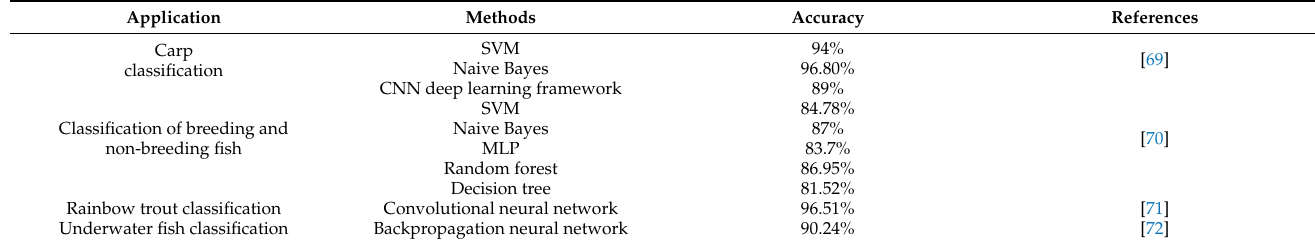
Table 3. The accuracy of the different classifiers in detection.